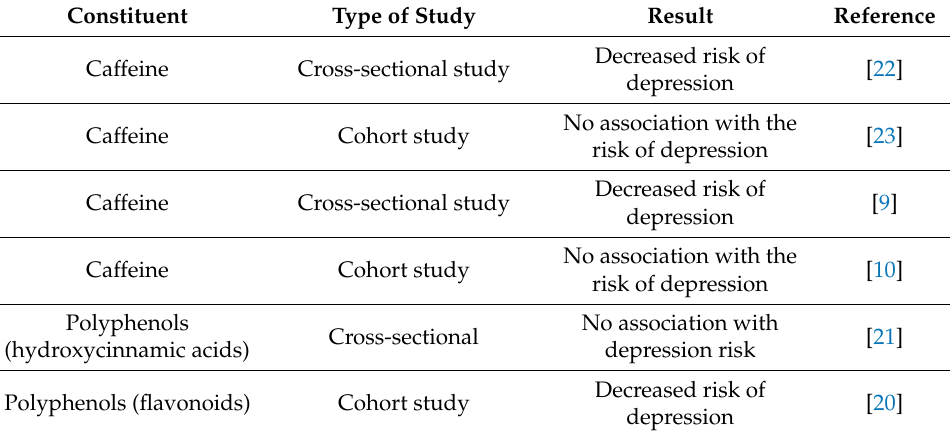
Table 1. Summary of the results of epidemiological studies investigating the association between depression risk and specific bioactive constituents found in